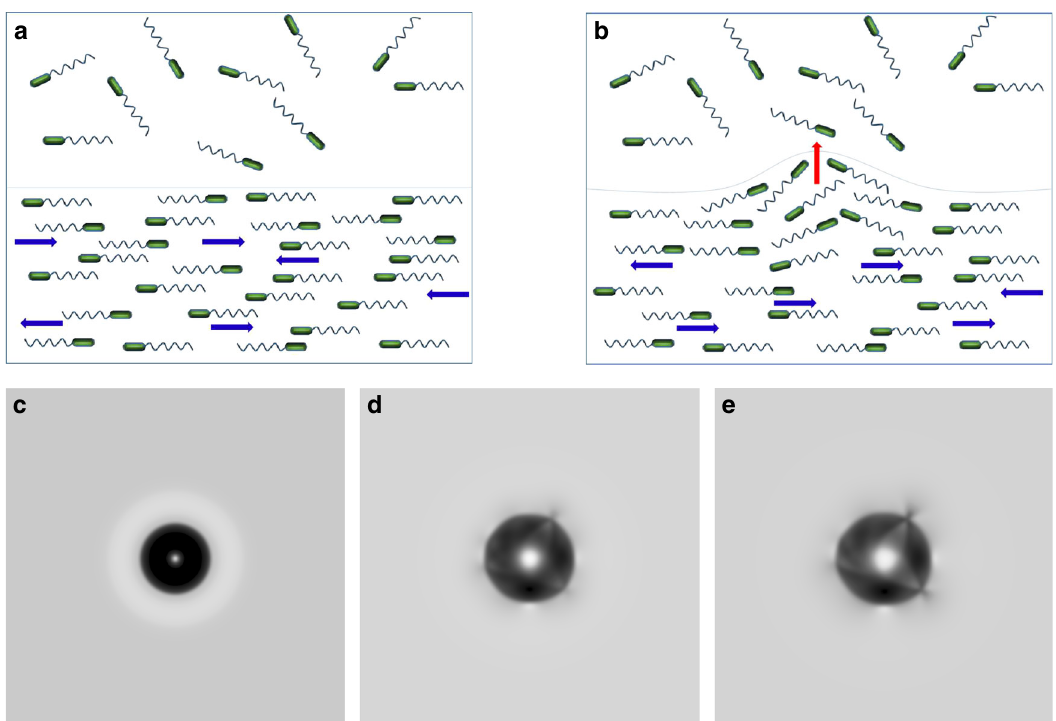
Fig. 5 Expansion of a spot. a , b The onset of polar order (indicated by red arrow) from a slightly perturbed nematic state. c – e A sequence of gray-scale images illustrating expansion and instability of the dense spot for t = 2 ( c ), t = 25 ( d ), t = 34 ( e ) dimensionless time units after cessation of rotation. The nondimensional concentration fi eld n is coded from white ( n = 0) to black (max( n )). Initial spot radius is r 0 = 20, and initial nondimensional concentration is n = n 0 = 8. Outside the spot, the concentration is n = n 1 = 0.85, i.e., dimensional n < n c . A depletion zone, seen as a bright halo, is imposed by